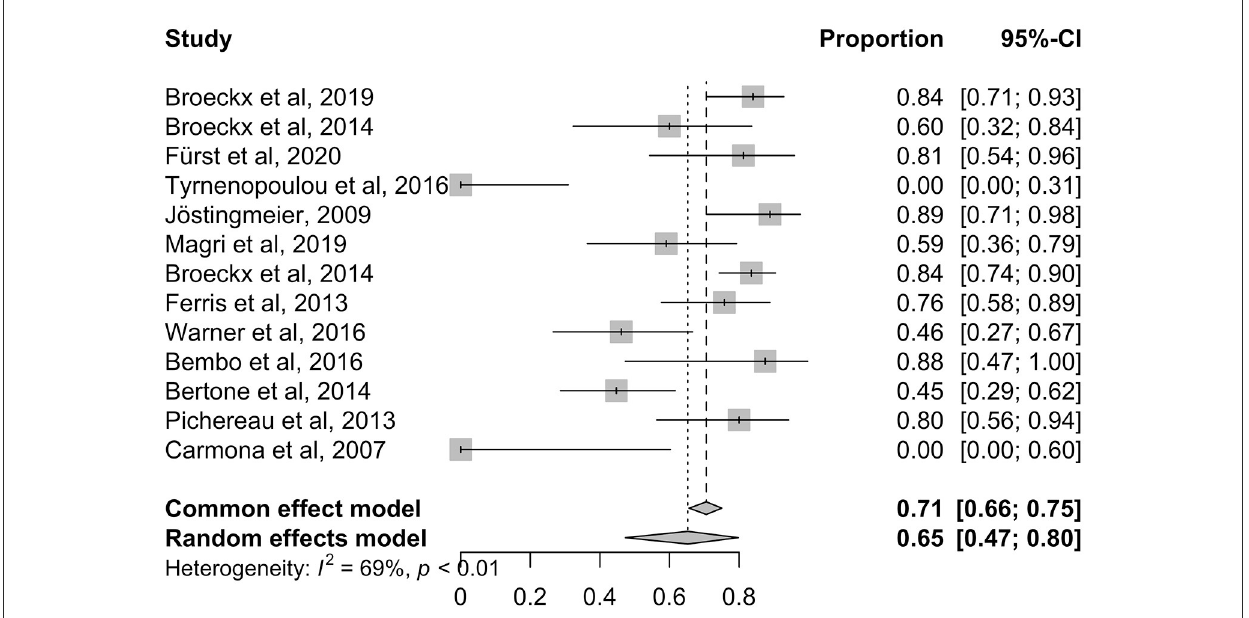
FIGURE4 Shows the ratios of the individual studies in the systematic analysis graphically with outliers.